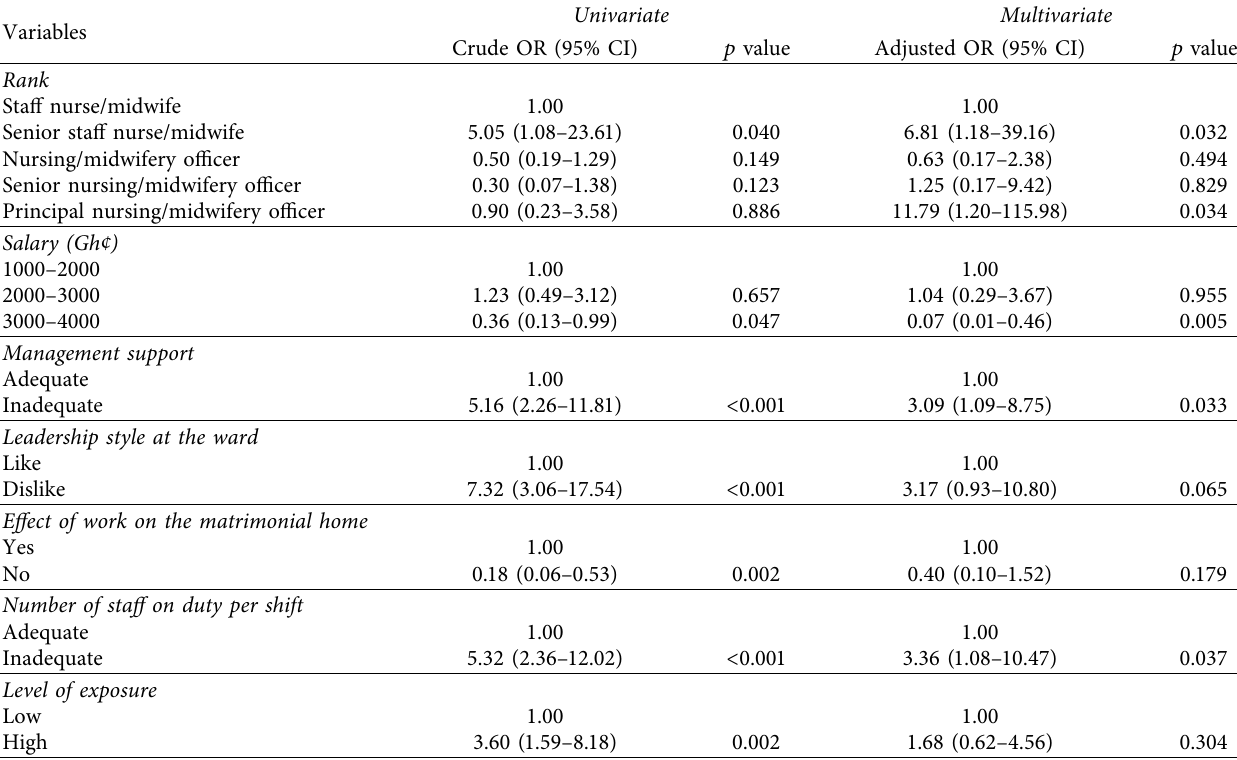
Table 3: Multivariate logistic regression analysis of the factors associated with turnover intention among study